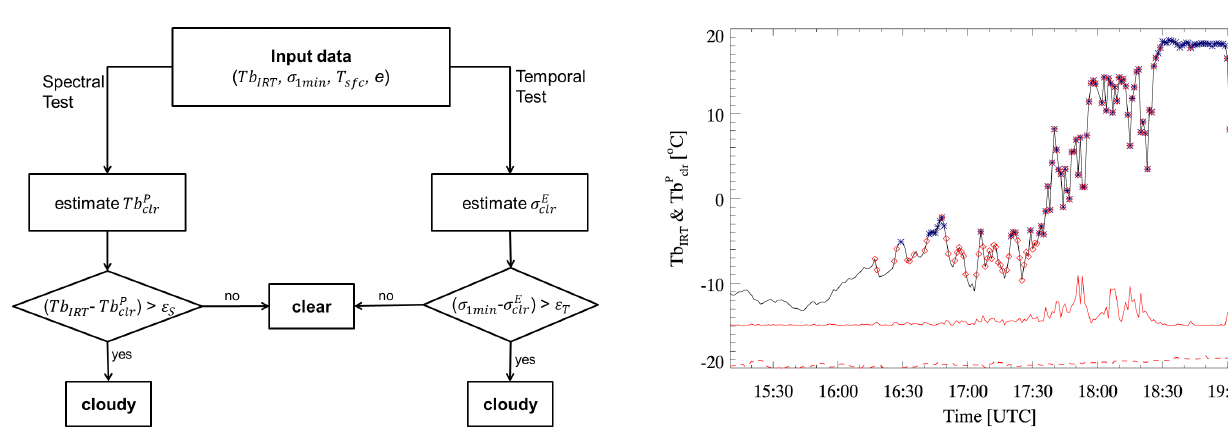
Figure 11. Time series of Tb IRT (black solid line) along with the Figure 10. Flow chart of the cloud detection algorithm using the predicted clear-sky Tb (Tb P ; red dashed line) and σ 1min (red solid measured Tb IRT along with the T sfc and e from the automatic clr line; for clarity, value − 15 ◦ C is added to the original value), for ) weather station for every minute. The estimated clear-sky Tb (Tb P clr about 3h of 27 June 2013. Symbols blue ∗ and red (cid:5) denote data ) are obtained by the Eqs. (5) and (6), and temporal variability ( σ E clr points classified as cloudy data determined by the spectral test and respectively. The threshold values of ε S (for spectral test) and ε T temporal test, respectively. Data points with both ∗ and (cid:5) are the (for temporal test) are set to 14 and 0.18K, respectively. points detected as cloudy by both